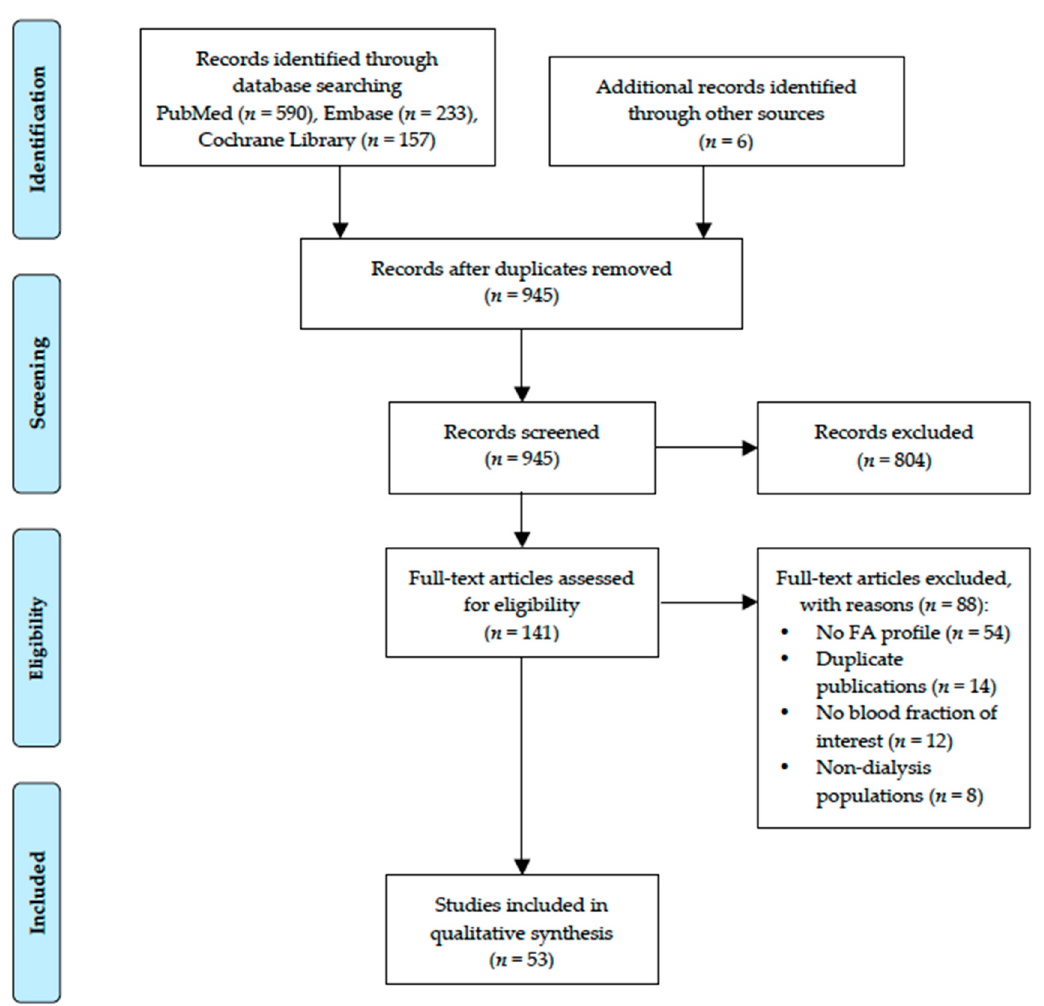
Figure 1. Preferred Reporting Items for Systematic Reviews and Meta-Analyses (PRISMA) study flow for literature search and study selection process. Abbreviation: FA, fatty acid.